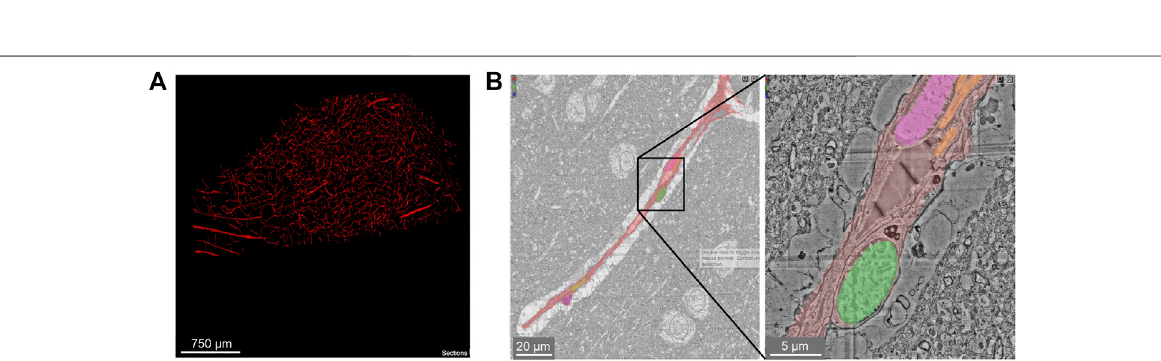
Frontiers in Cell and Developmental Biology |